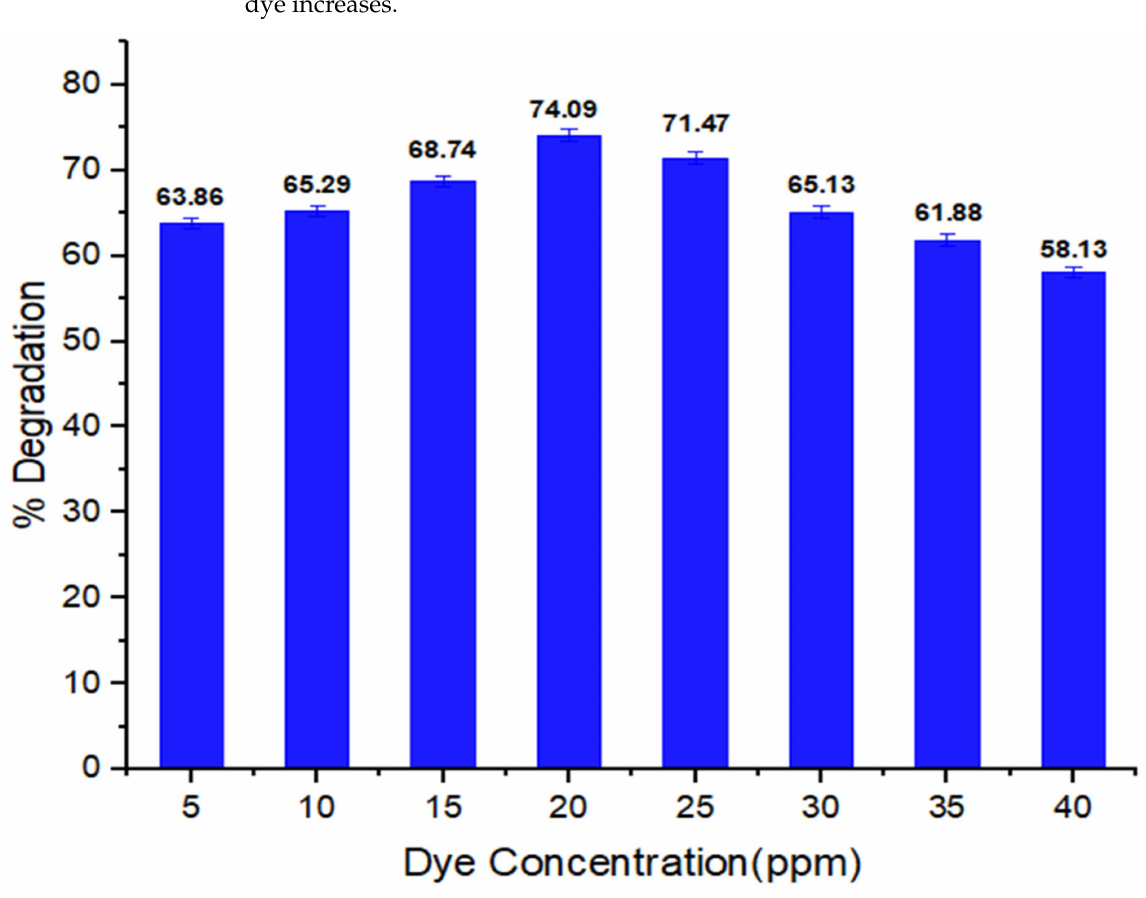
Figure 3. Effect of Dye Concentration on % degradation of